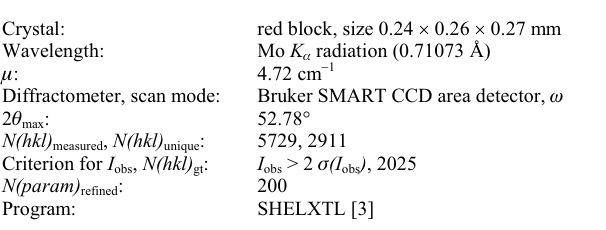
Table 1. Data collection and handling.